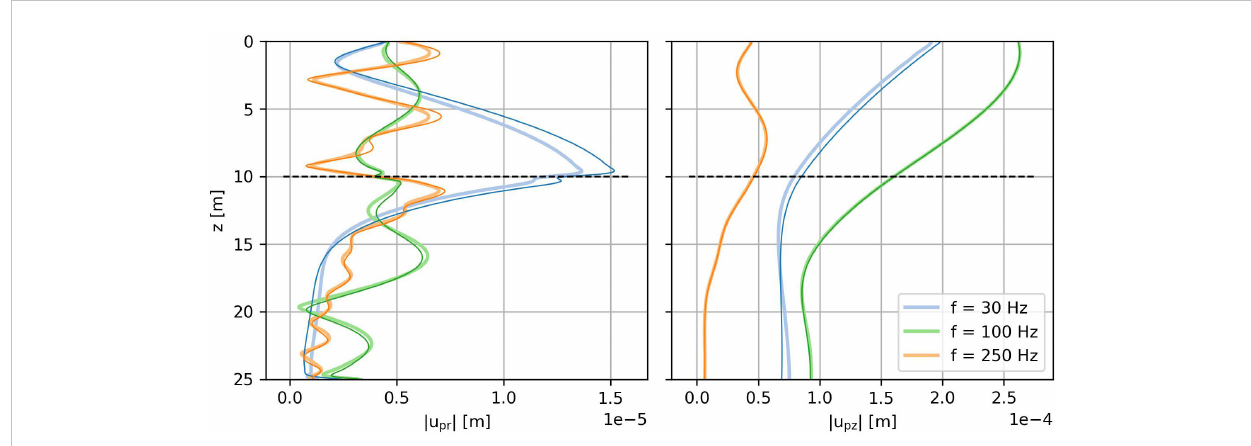
FIGURE 2 Comparison of the amplitudes of the pile vibrations between Comsol (dark colors) and the present model (light colors) for a harmonic load of 1 MN on top of the pile at 30, 100 and 250